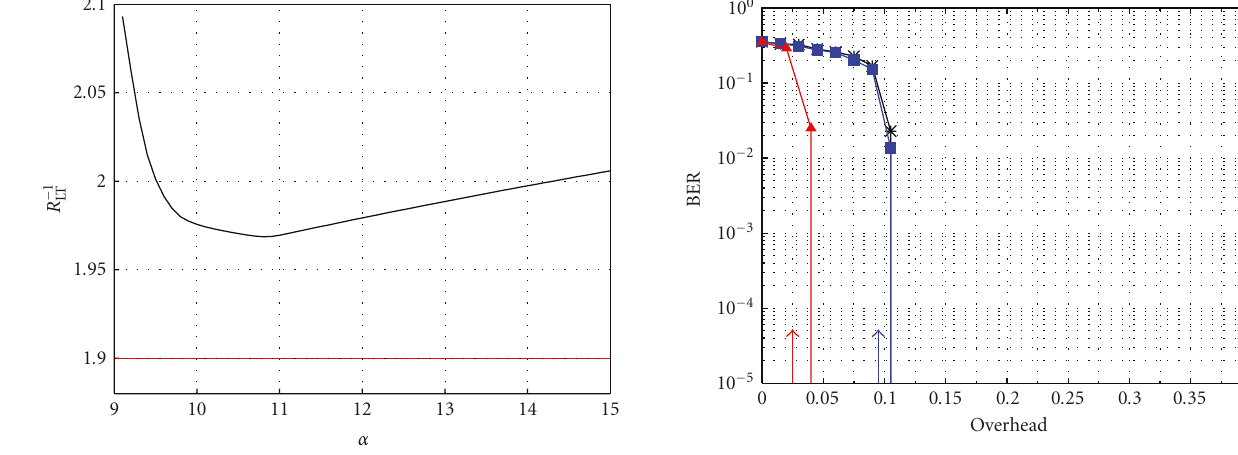
Figure 3: Asymptotic rate of an LT code: R − 1 versus α . For LT increasing values of α , we optimize a distribution to match a (3,60) regular LDPC precode of rate R p = 0 . 95 on a BIAWGN channel Figure 4: BER versus overhead for a Raptor code defined with of capacity C = 0 . 5 ( σ = 0 . 9786),. and compute the a posteriori a regular (3,60) LDPC precode of size N = 65000. We compare rate R LT = Ω (cid:3) (1) /α . It appears that is an optimal value for α that Ω B ( x ), a distribution that we optimized for joint decoding, to Ω E ( x ) , that is, that minimizes the asymptotic overhead. minimizes R − 1 proposed in [5] under tandem decoding (squares) and under joint LT decoding (stars). The thresholds of the corresponding distributions are also reported on the figure (c.f. Section 3.3). Simulations are run on a BIAWGN channel of capacity C = 0 . 5 ( σ = 0 . 9786) with 600 decoding